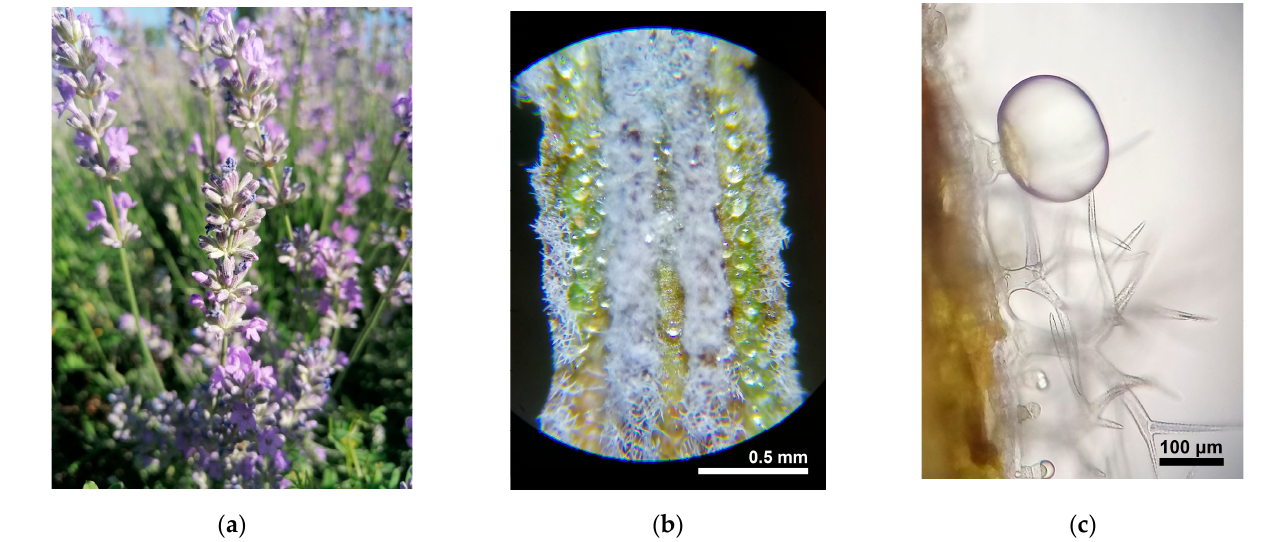
Figure 1. Aspects of Lavandula angustifolia ‘Sevtopolis’, one of the frequently cultivated genotypes in Eastern Europe: ( a ) inflorescence; ( b ) glandular trichomes located in the calyx grooves and branched trichomes with protective role, magnified 160×; ( c ) microscopic sideview of a glandular trichome and branched protective trichomes in the background, magnified 400× (original photos by Ioana C., 2022).